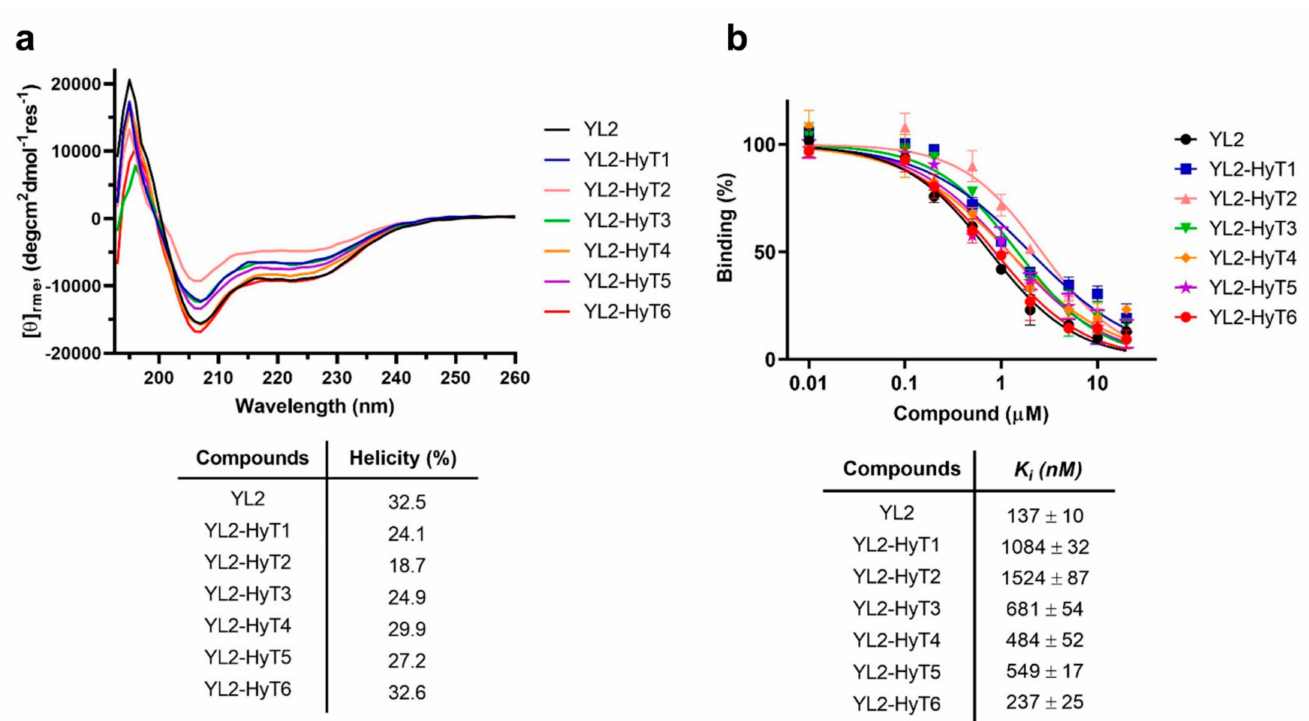
Figure 3. ( a ) CD spectra and calculated helicities (%) of YL2-HyT1–6 and YL2 (50 µ M), ( b ) inhibition curves of YL2-HyT1–6 and YL2 for fluorescein-labeled STAT-6 peptide binding to SRC-1 determined by competitive FP assays. Error bars indicate standard deviation from three independent